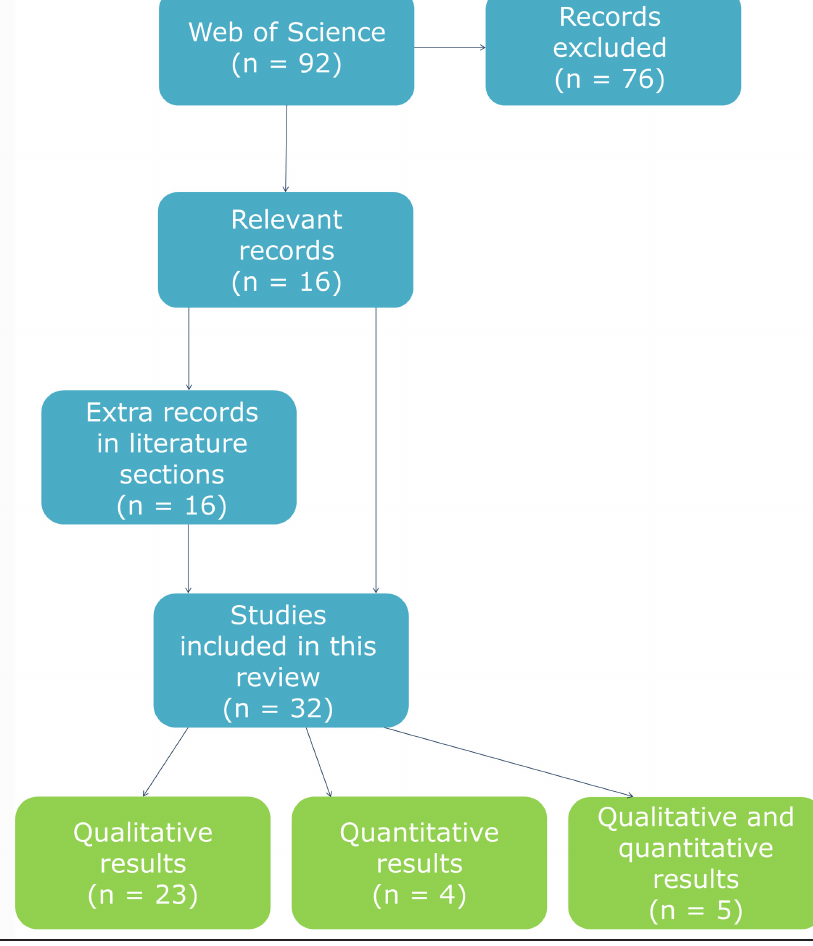
Figure 2: Inclusion diagram of studies used in this literature